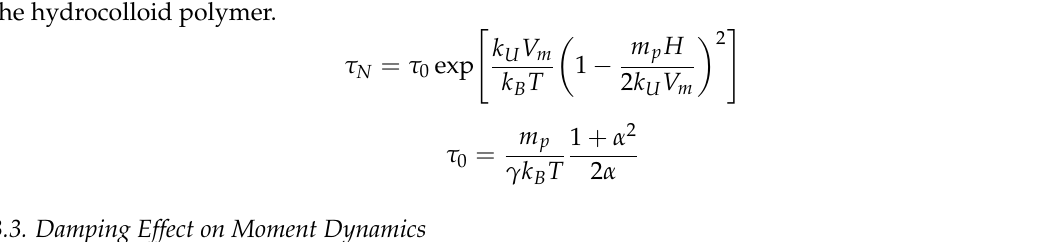
( H ) of the immobilized CMEAD- γ Fe 2 O 3 N